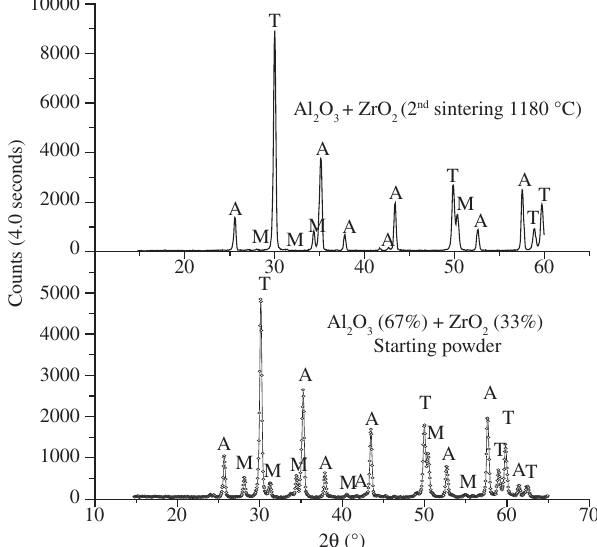
Figure 2. X ray diffraction of In-Ceram ® Zirconia starting powder and after sintering.